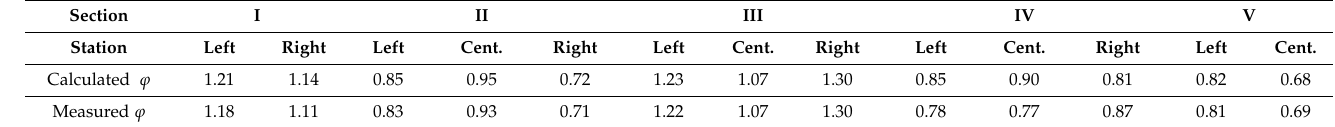
Table 4. Comparison between measured and calculated ϕ .